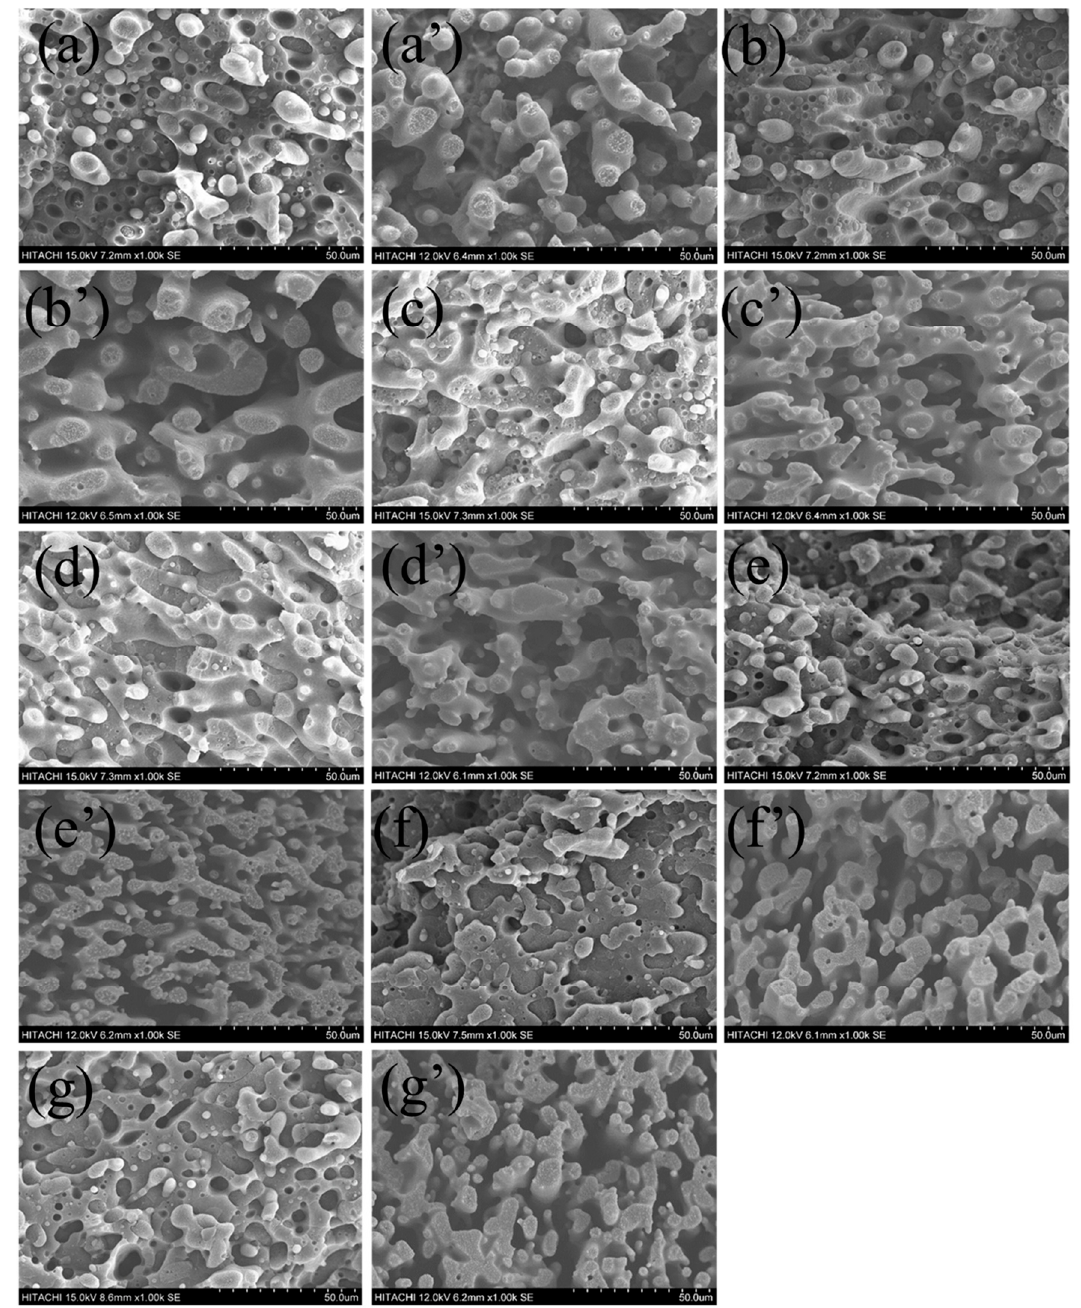
Figure 2. SEM of PLA/HDPE (70/30) blends with different carbon black (CB) loadings, ( a, a’ ) 1.5 wt %, ( b, b’ ) 3.0 wt %, ( c, c’ ) 5.0 wt %, ( d, d’ ) 7.5 wt %, ( e, e’ ) 10.0 wt %, ( f, f’ ) 12.5 wt %, and ( g, g’ ) 15.0 wt %.